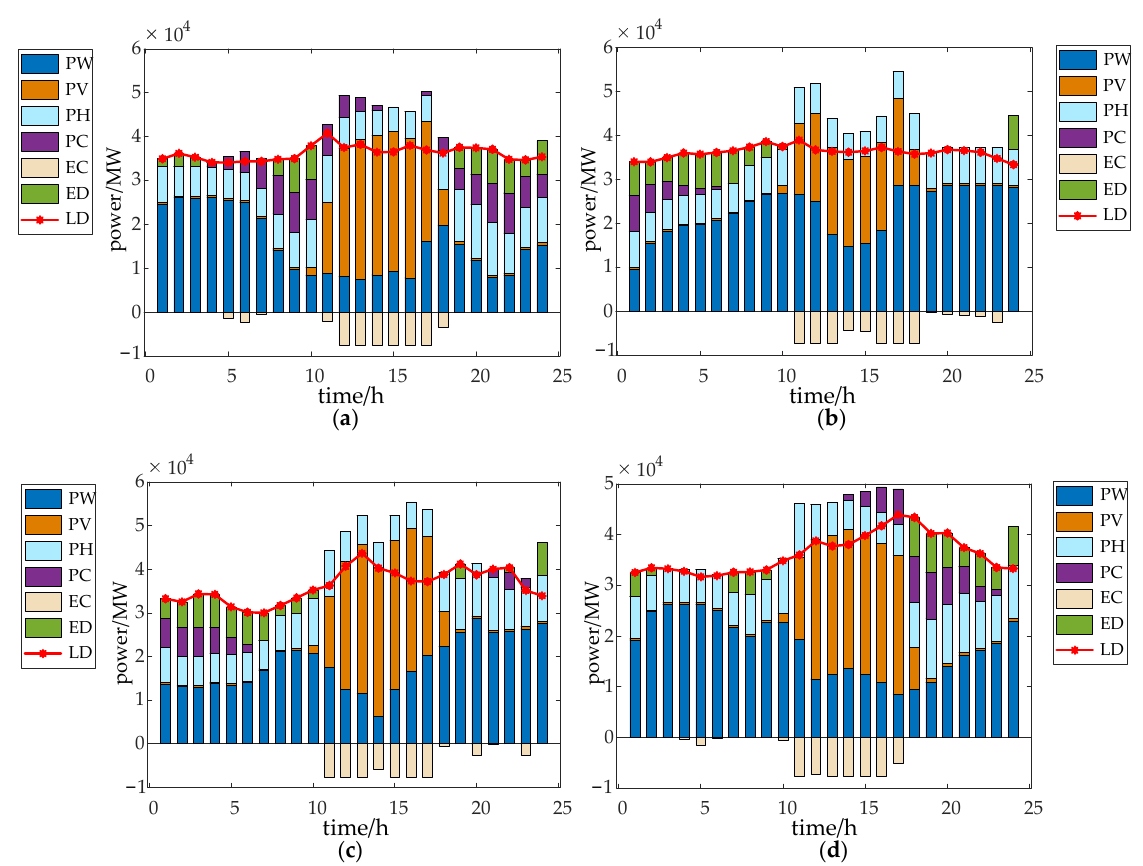
Figure 14. The operational results in 2030. ( a ) typical day 1; ( b ) typical day 2; ( c ) typical day 3; ( d ) typical day 4.